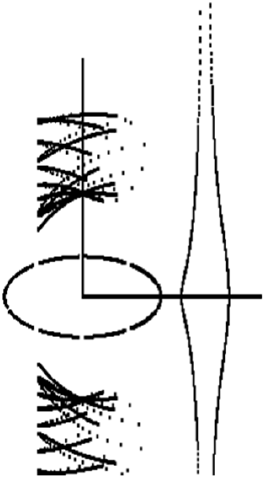
Figure 17. q = 2.5, KG = 120, and DK = 140.